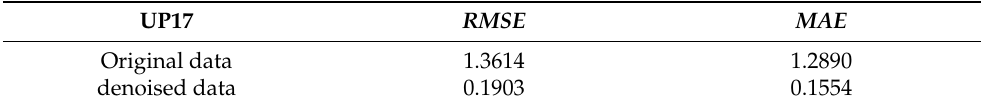
Table 5. Statistics of prediction evaluation indexes for original and denoised data of UP17 measure- ment points.